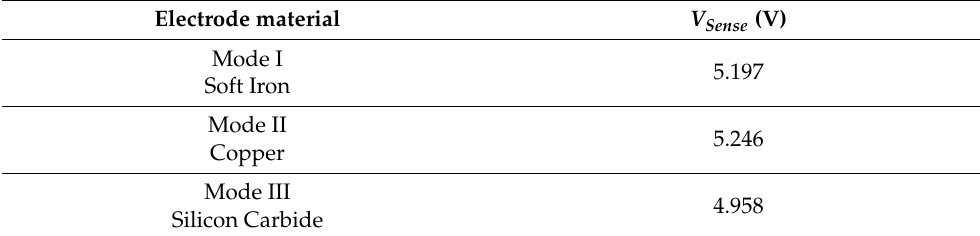
Table 8. Voltage sensed according to changes in electrode